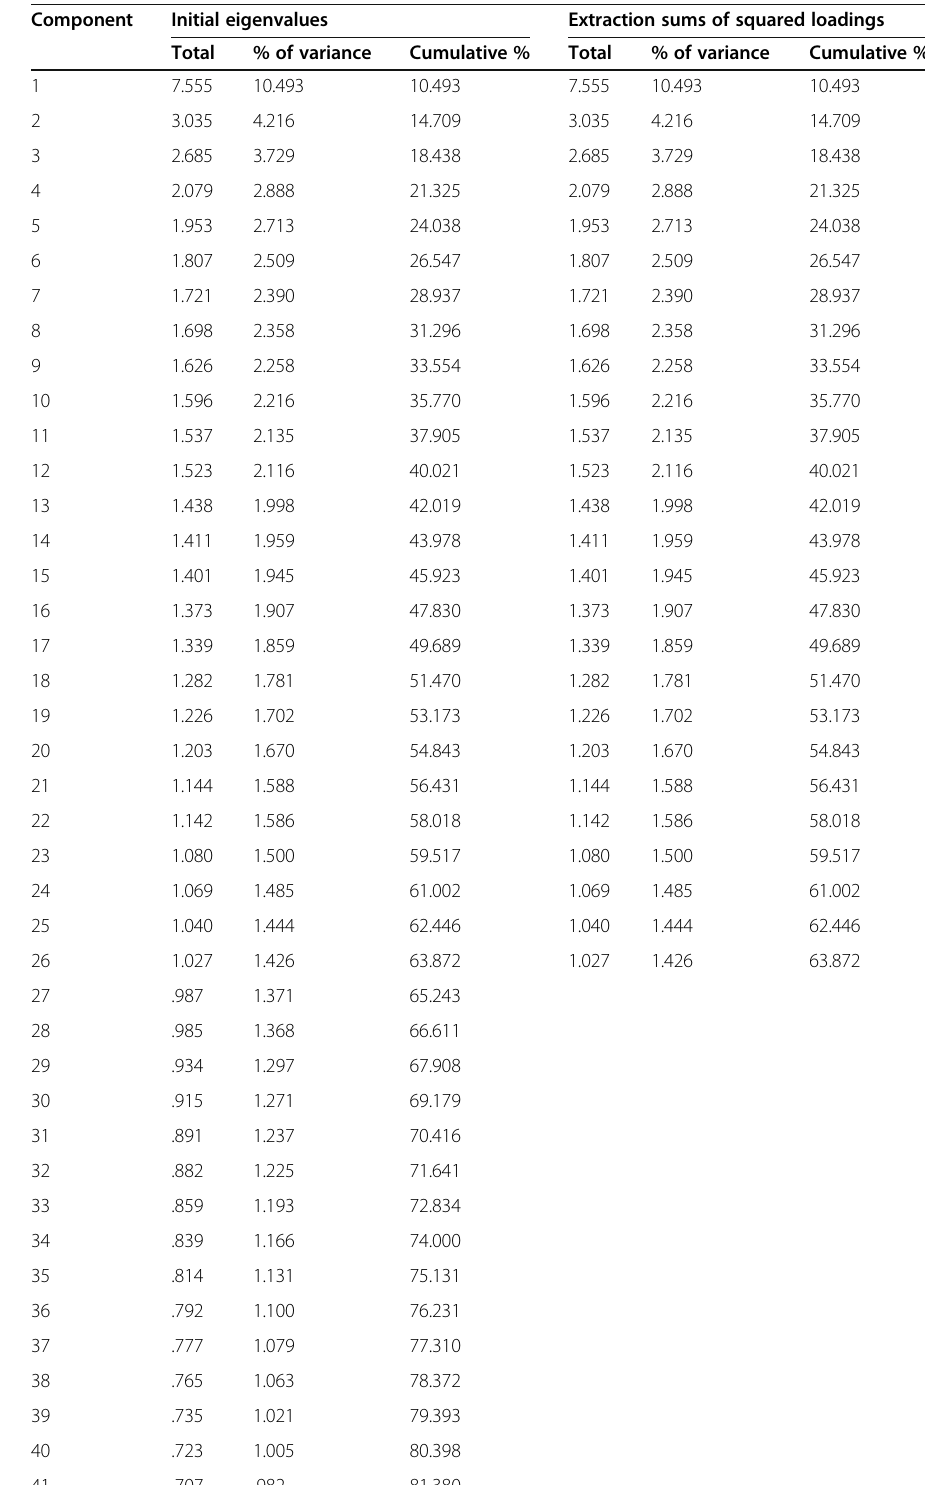
Table 7 Factor extraction total variance